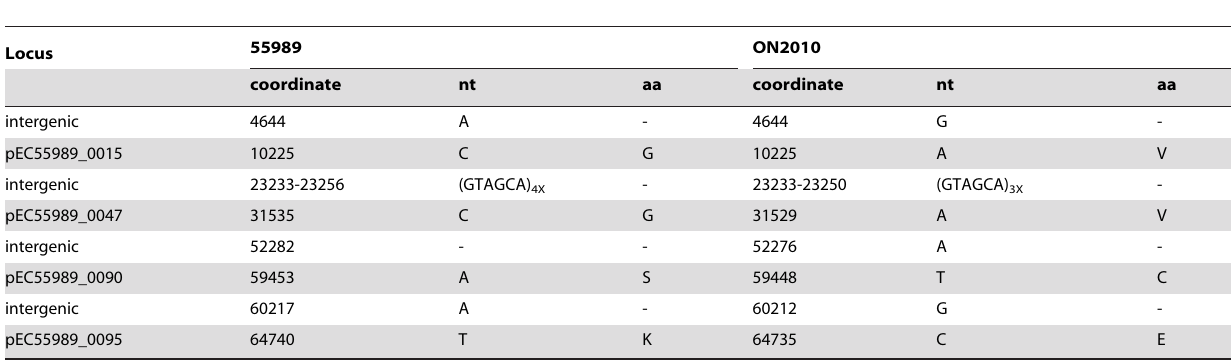
Table 2. Differences between the plasmids in the ON2010 and 55989 strains.